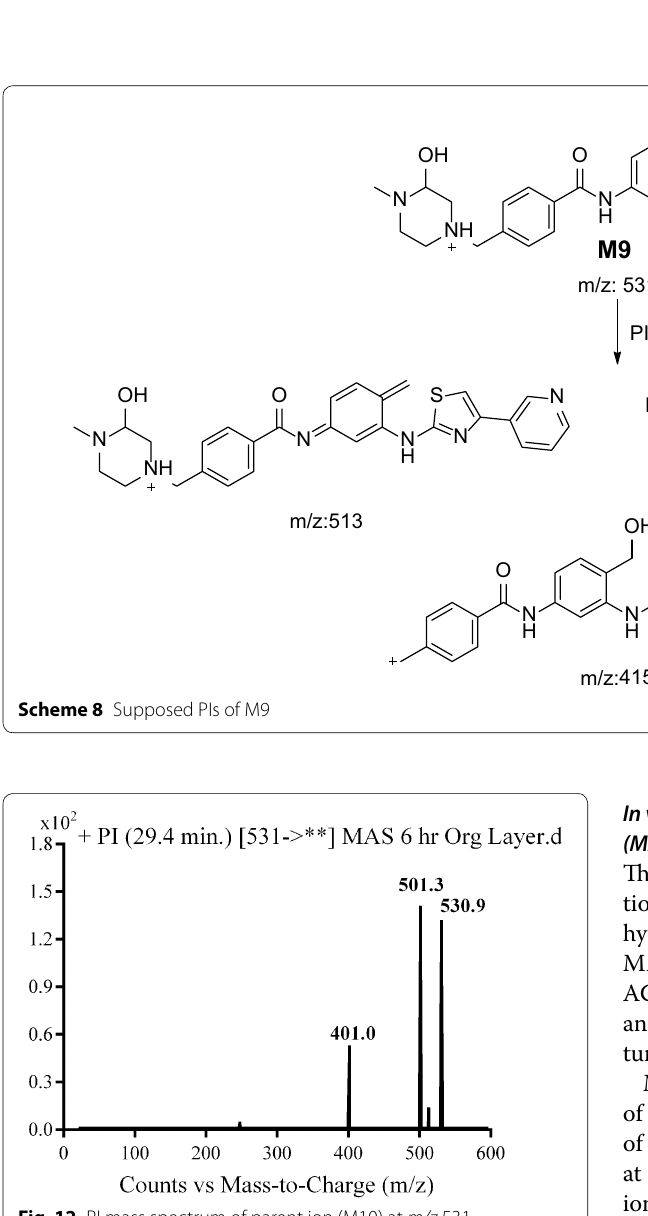
Fig. 12 PI mass spectrum of parent ion (M10) at m/z